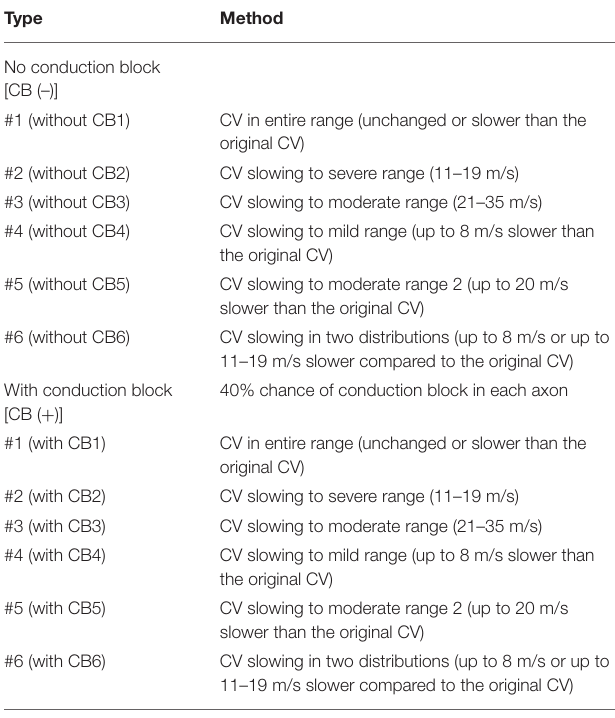
TABLE 2 | Patterns of demyelinating